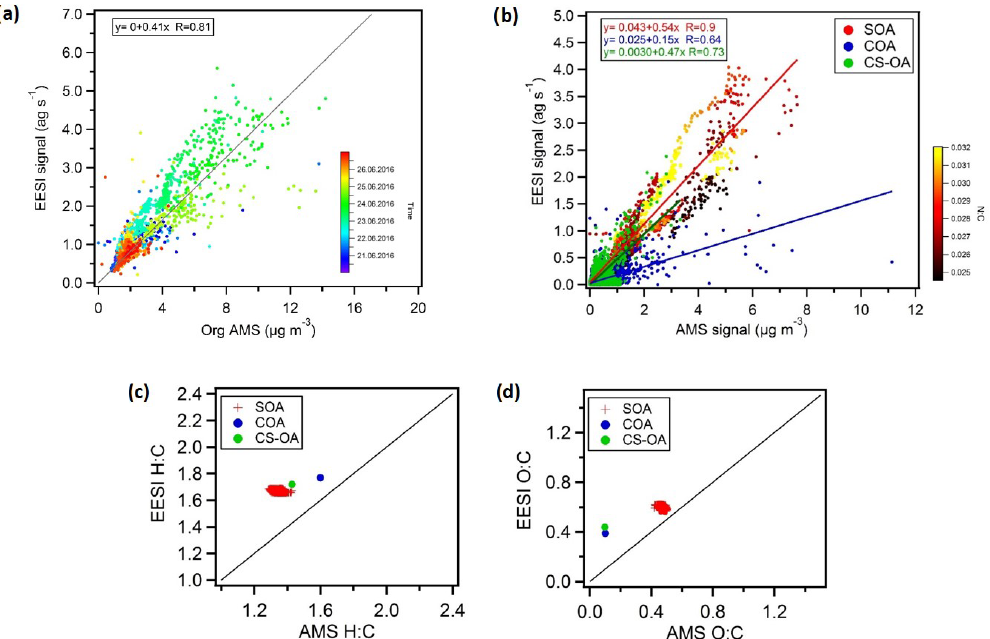
Figure 10. (a) Total aerosol signal measured by the EESI-TOF-MS versus OA measured by the AMS, with the points coloured by time. An overall bulk sensitivity to OA can also be estimated from (a) (1 . 9 × 10 − 8 ). (b) Correlations of the CS-OA and COA factors and of SOA (total SOA estimated by EESI-TOF-MS and AMS) from the two instruments, where SOA is colour-coded by the N : C ratio (yellow dots represent N : C ≥ 0 . 032). We estimate bulk sensitivities of 3 . 2 × 10 − 8 ions per molecule to SOA, 2 . 8 × 10 − 8 ions per molecule to CS-OA, and 9 . 0 × 10 − 9 ions per molecule to COA. (c, d) Atomic ratios, i.e. H : C and O : C ratios for SOA and the CS-OA and COA